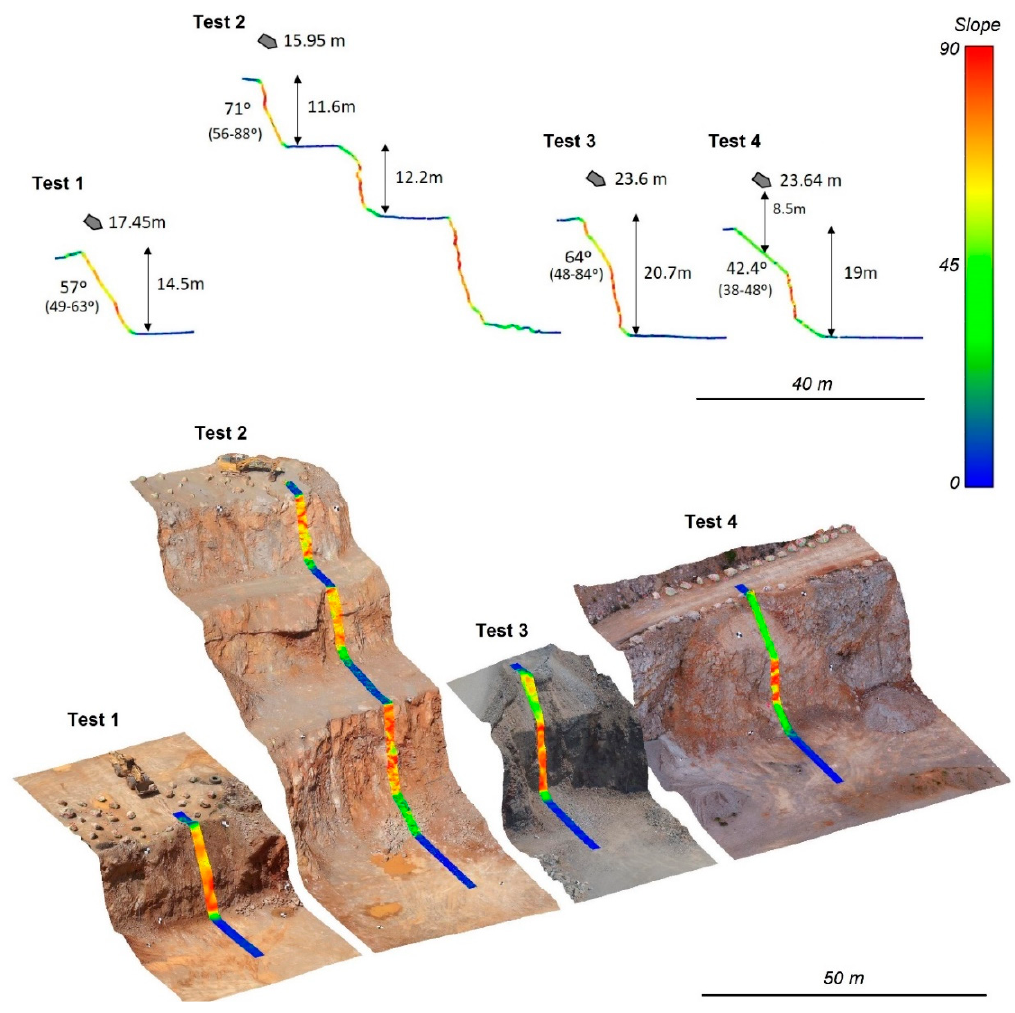
Figure 2. Profiles of the 4 settings. Local slope angles are represented with a color code and both the height of drop and the average angle of the impact surface are indicated as well. 3D models of the 4 fragmentation test settings, colored according to the local slope angle.